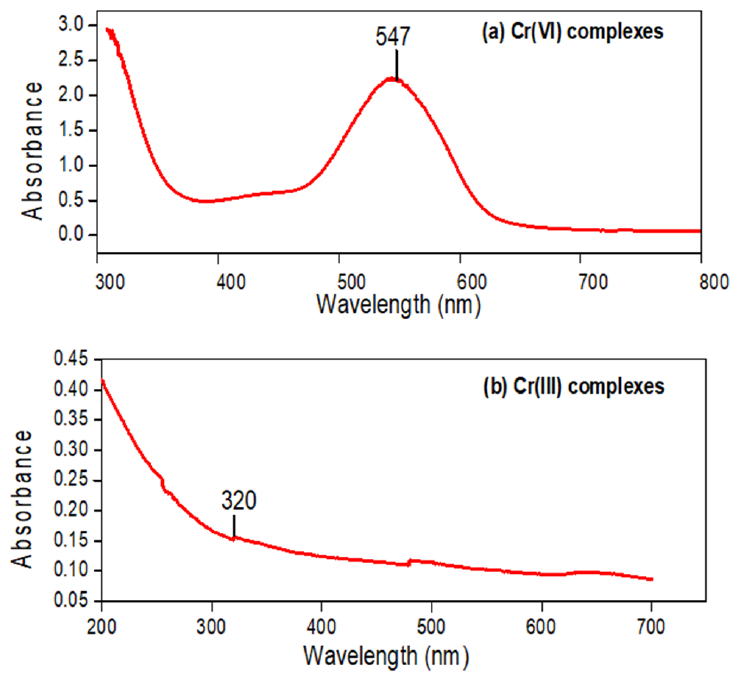
Figure 8. UV/Vis spectra of ( a ) Cr(VI) and ( b ) Cr(III) complexes for untreated and treated wastewater.